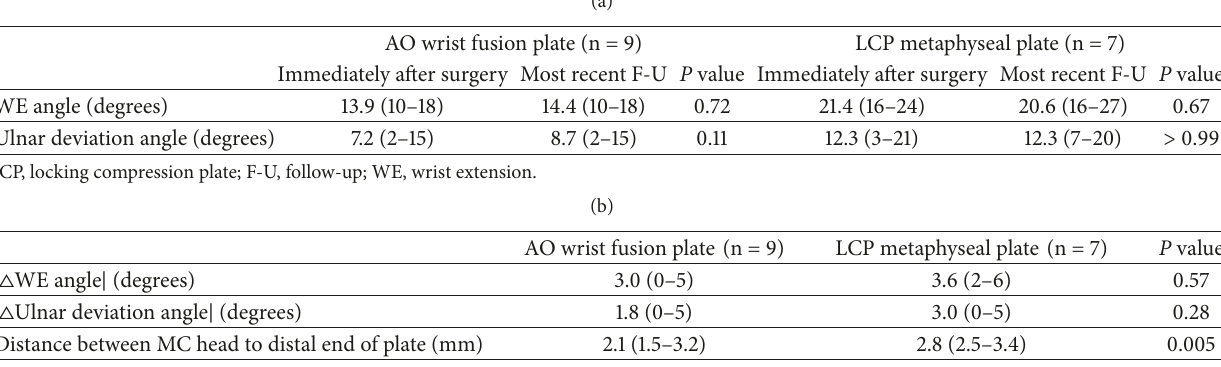
Table 3: Radiographic measurements. (a) Comparison of immediately after surgery versus the most recent follow-up. (b) Comparisons of the AO wrist fusion plate and the LCP metaphyseal plate